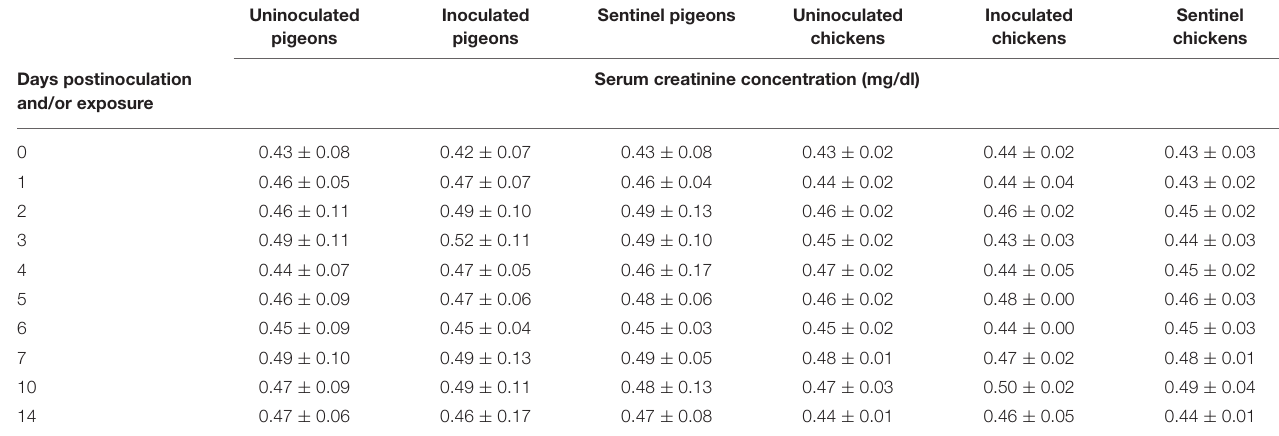
TABLE 12 | Mean serum creatinine concentration of pigeons and chickens following inoculation with and/or exposure to a very virulent infectious bursal disease virus.